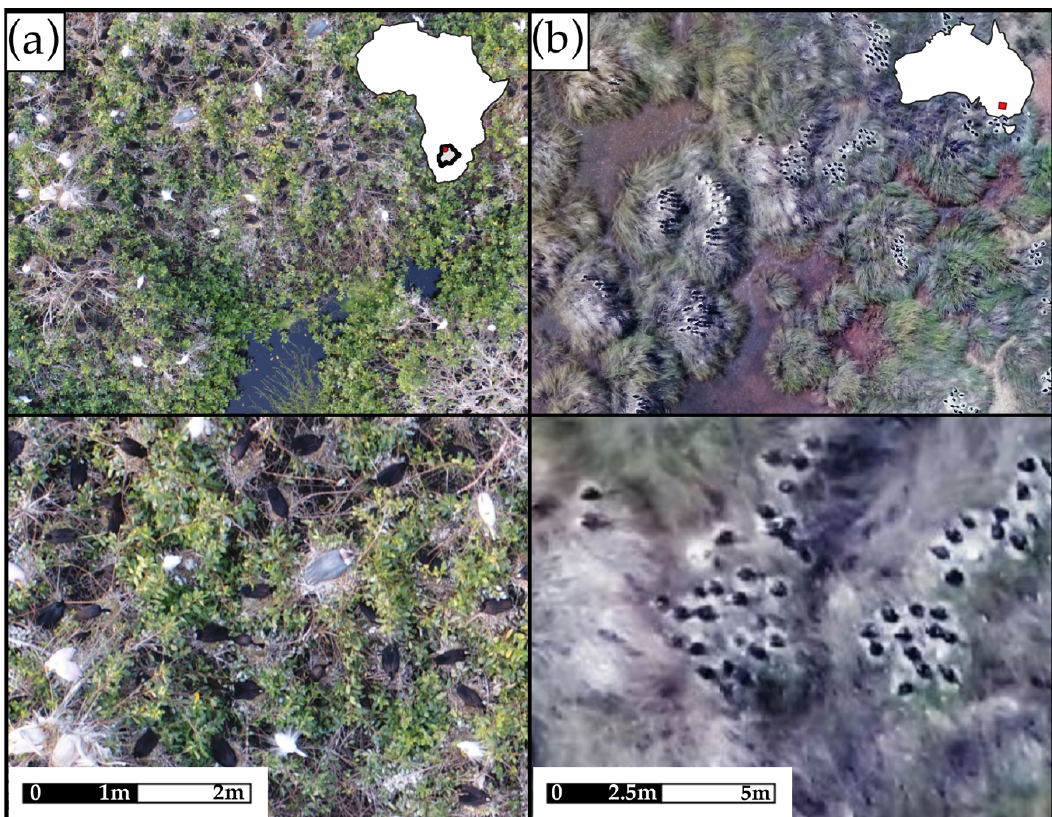
Figure 1. Locations’ imagery at two resolutions and an example of the segmentation process of the two waterbird colonies: ( a ) Kanana (Okavango Delta, Botswana) taken using a Phantom 4 Advanced at 20 m, and ( b ) Eulimbah (Lowbidgee floodplain, Australia) using a Phantom 3 Professional at 100 m.